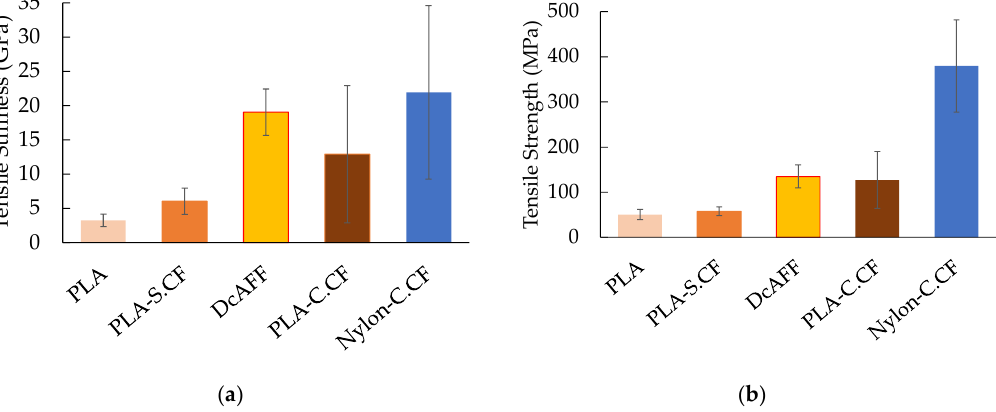
Figure 7. Comparison of ( a ) tensile stiffness; ( b ) tensile strength between the DcAFF (HiPerDiF-PLA) printed as a single layer 3D printed part, 20 tested specimens, and other composite 3D printings from publications: PLA [5,7,27 – 33] , PLA-short carbon fibre (PLA-S.CF) [6,27,30 – 32,34 – 37] , PLA-continuous carbon fibre (PLA-C.CF) [38 – 42] , and Markforged continuous carbon fibre (nylon-C.CF) [6,14,43 – 48] .